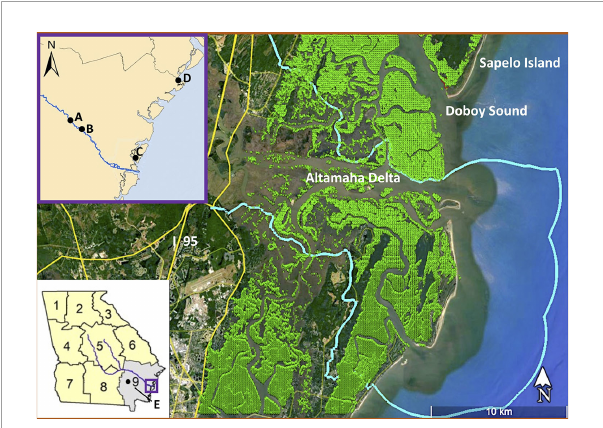
FIGURE 1 Study site and environmental data sources. A - River Discharge (USGS Doctortown, Gauge 02226000); B - River Nutrients (USGS near Gardi), C - Air Temp & Precipitation (NOAA Sapelo Island), D - Sea Level & Tidal Data (NOAA Fort Pulaski, Gauge 8670870), E - PDSI (NOAA NCDC). Light blue is the contour of the HUC in which the biomass was quanti fi ed, the light green pixels are those identi fi ed as Spartina alterni fl ora